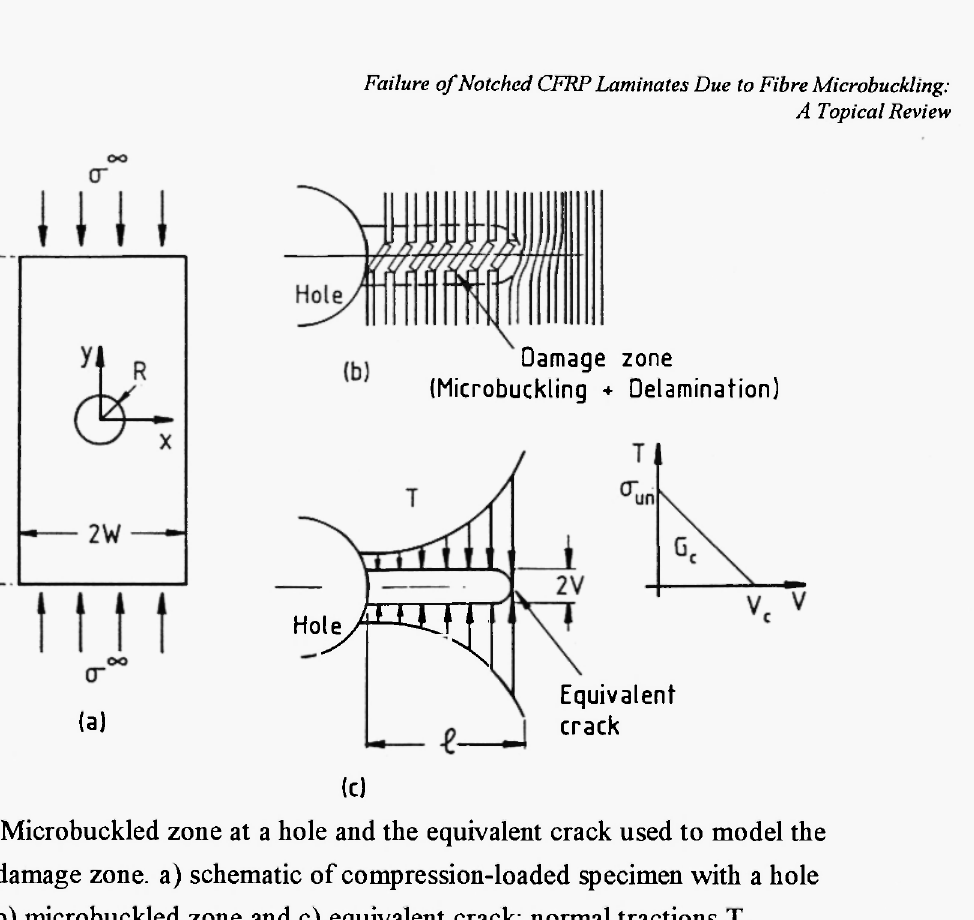
Fig. 3 Microbuckled zone at a hole and the equivalent crack used to model the damage zone, a) schematic of compression-loaded specimen with a hole b) microbuckled zone and c) equivalent crack: normal tractions T, closing displacement 2v. Gc is the critical value for the enegry release rate, and equals the area under the T-2v plot